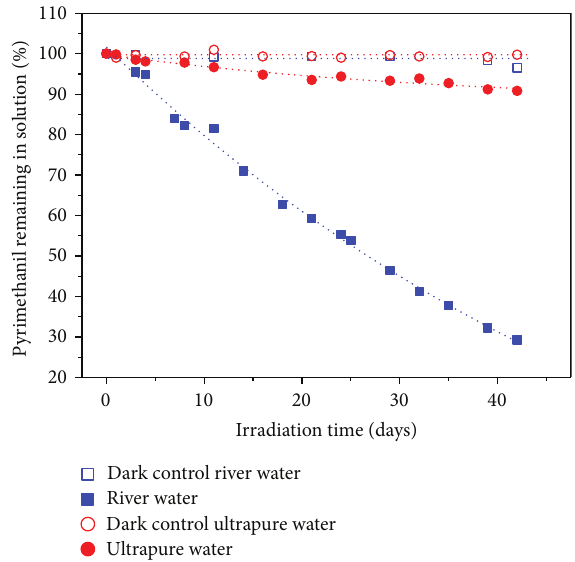
Figure 4: Photodegradation of pyrimethanil in (open red circle, solid red circle) ultrapure and (open blue square, solid blue square) river water under simulated solar irradiation.